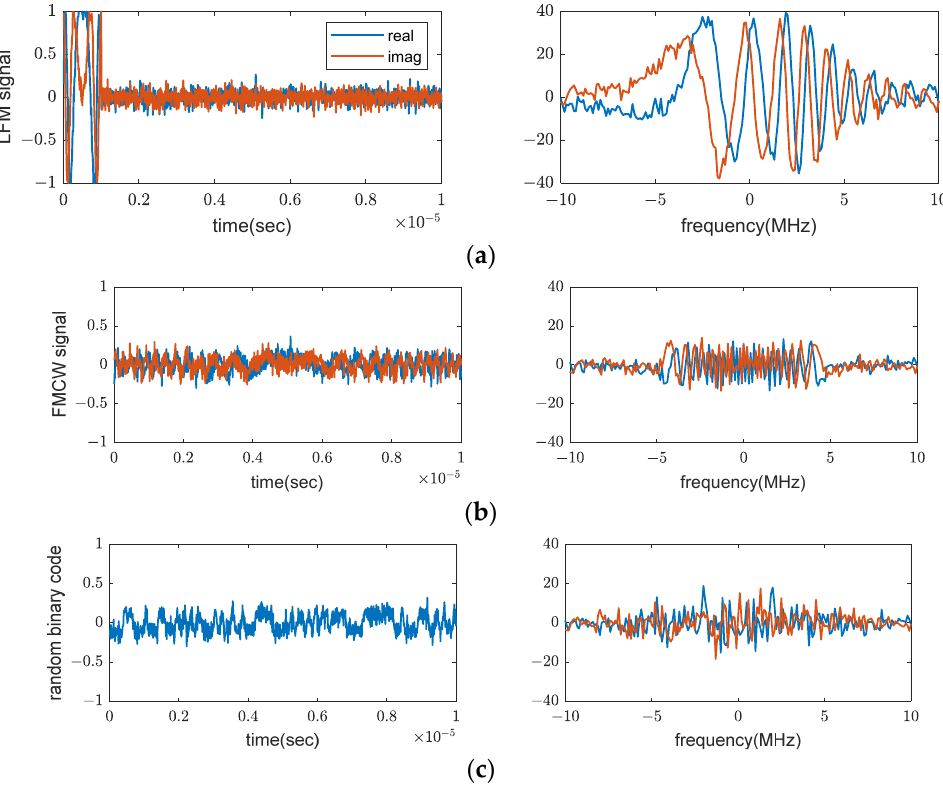
Figure 1. Comparison among three waveforms: LFM pulse, FMCW, and random code. ( a ) LFM pulse; ( b ) FMCW signal; ( c ) Random binary code.